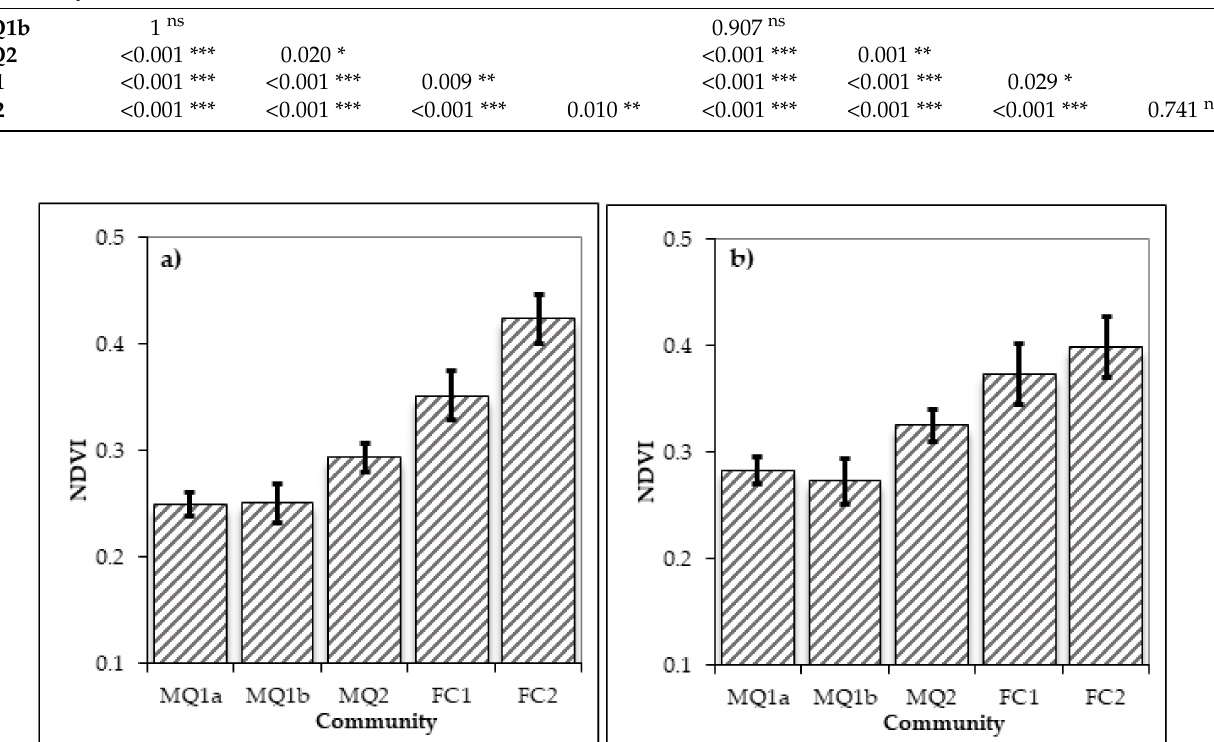
Figure 9. Mean NDVI values and 95% confidence intervals for the different communities in August 2011 ( a ) and July 2021 ( b